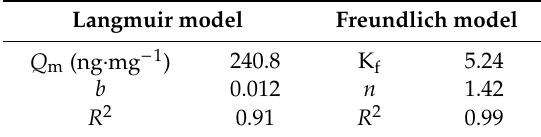
Table 3. Parameters Freundlich and Langmuir model of MIP1.